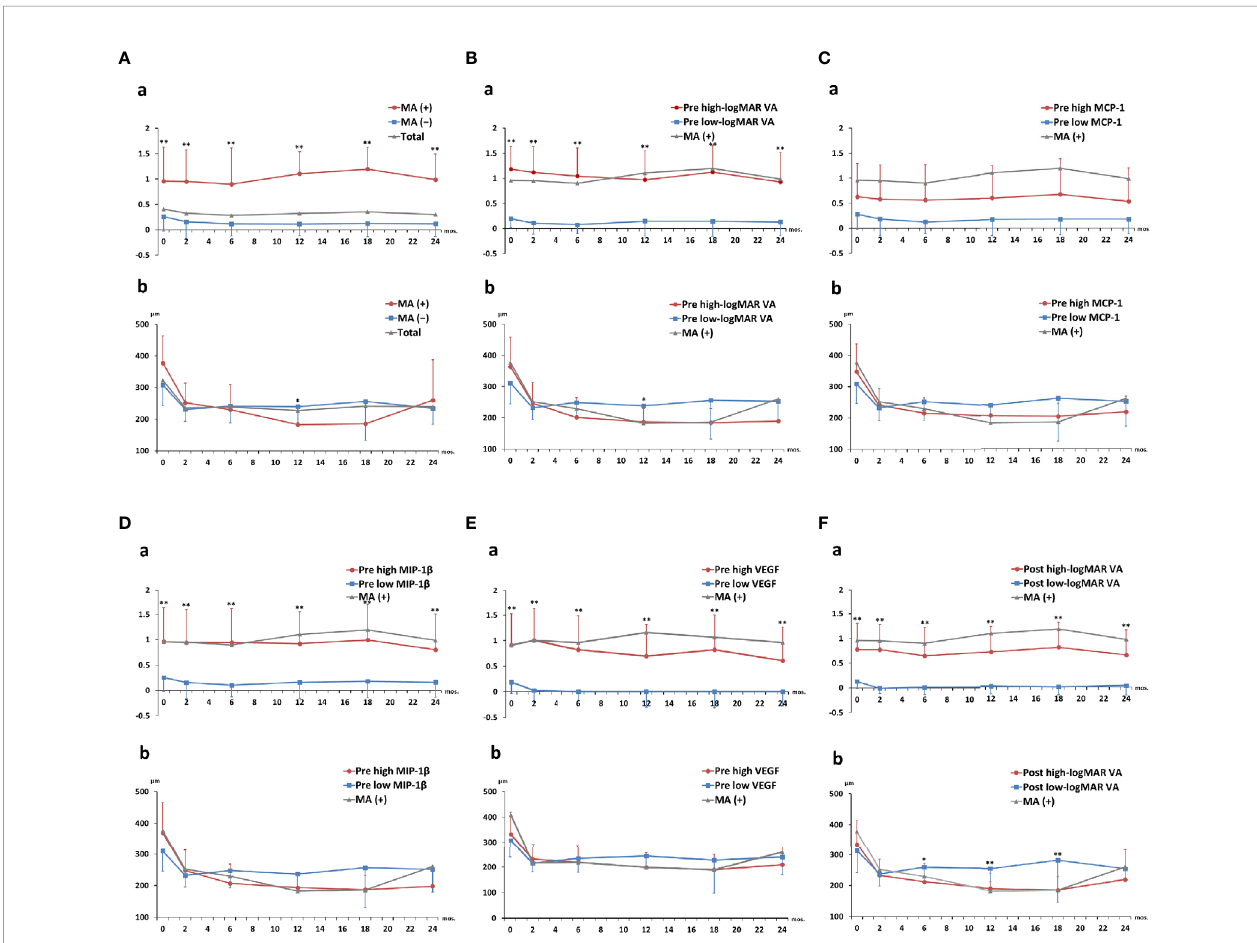
FIGURE 6 | Two-year clinical courses of visual acuity and central macula thickness in nAMD group divided by the presence of macular atrophy, visual acuity, or levels of aqueous humor cytokines. Two-year clinical courses of (a) logMAR VA and (b) CRT in nAMD eyes under IVA treatment for 2 years, classi fi ed by (A) presence or absence of MA incidence and above or below cutoff values of (B) pre-IVA logMAR VA, (C) pre-IVA level of MCP-1, (D) pre-IVA level of MIP-1 b , (E) pre-IVA level of VEGF, and (F) post-IVA logMAR VA are shown. The cutoff values were the same as those used in Kaplan – Meier curves (). Data are expressed in mean (close circle) and standard deviation (error bar). CRT, central retinal thickness; IVA, intravitreal injection of a fl ibercept; MA, macular atrophy; logMAR, logarithm of the minimum angle of resolution; MCP-1, monocyte chemotactic protein-1; MIP-1 b , macrophage in fl ammatory protein; nAMD, neovascular age-related macular degeneration; VA, visual acuity; VEGF, vascular endothelial growth